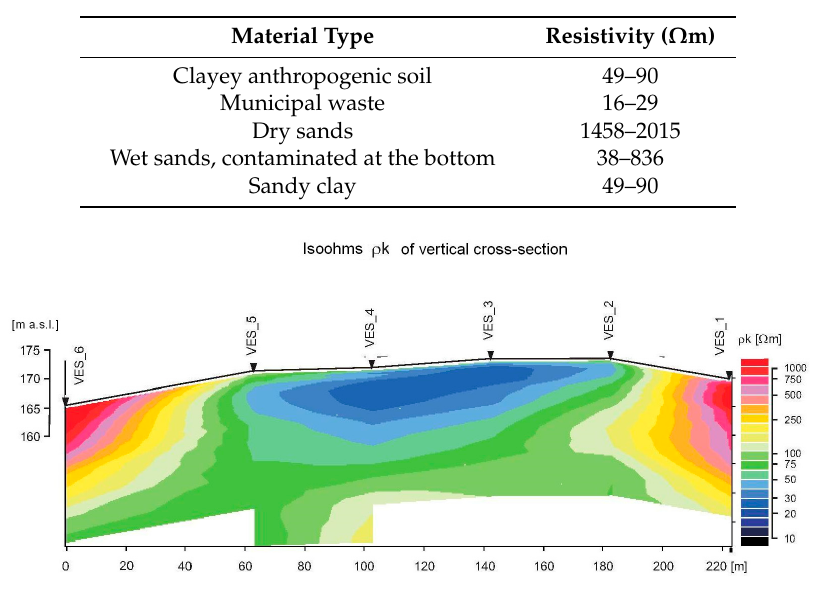
Figure 8. Results of the quantity interpretation of the geophysical investigation. Table 4. Geoelectrical investigation results.